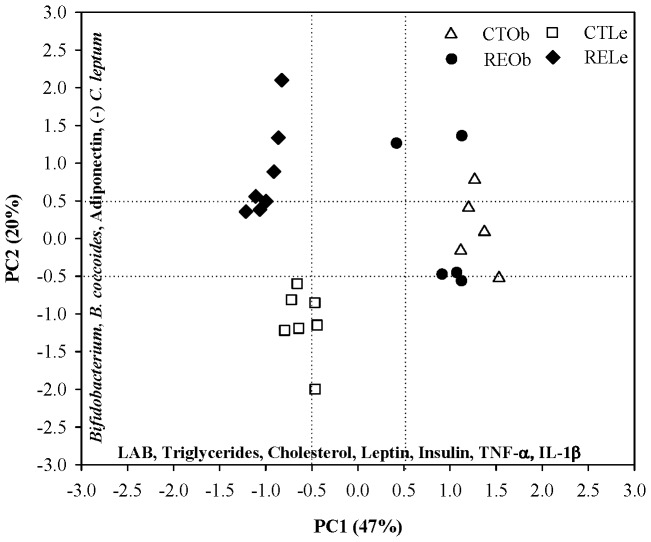
Discriminant principal component analysis (PCA).Analysis of the caecum bacterial groups in Zucker male obese (Ob) and lean (Le) rats and the serum triglycerides, cholesterol, leptin, insulin, adiponectin, TNF-α, and IL-1β previously measured in the same animals [16], [17]. Plot analysis of the four animal groups: control lean rats (CTLe, open squares), RE-supplemented lean rats (RELe, black diamonds), control obese rats (CTOb, open triangles) and RE-supplemented obese rats (REOb, black circles).